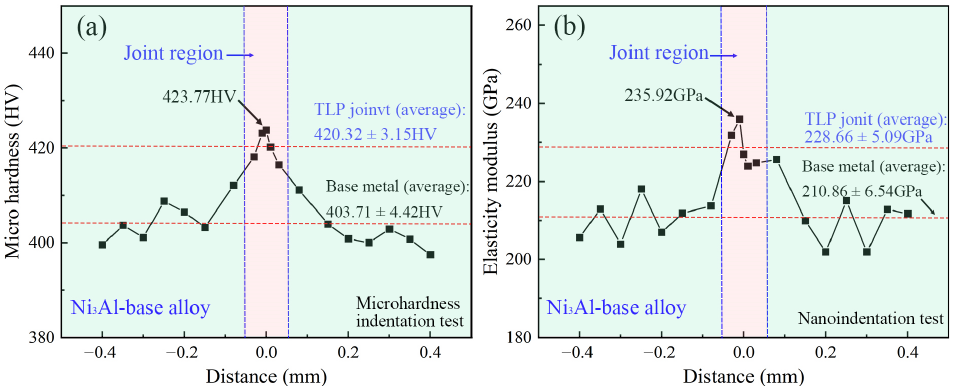
Figure 10. Microhardness curve and elasticity modulus curve of TLP-diffusion-bonded joint using low-B interlayer. ( a ) Micro hardness of TLP joint; ( b ) Elasticity modulus of TLP joint.